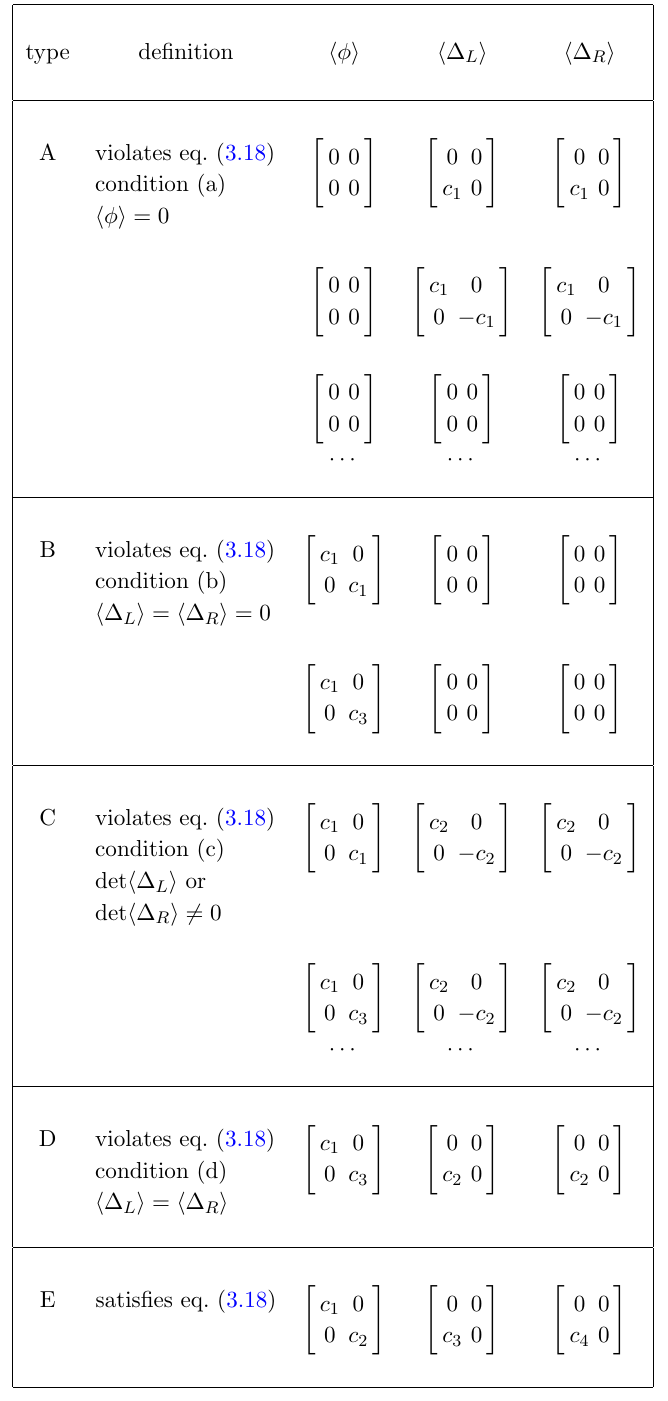
Table 1 . VEV alignments of various types of minima found in the numerical search. Except for type E, each type is de(cid:12)ned by a relation that violates the good vacuum conditions in eq. (3.18). The typical VEV alignments in each type are listed in the 3rd{5th columns, with \ c i " ( i = 1 ; 2 ; 3 ; 4) standing for independent nonzero values. Note that other VEV alignments that can be converted to the ones in this table are not shown (see the main text for more details about this issue), and \ " indicates that the enumeration is not (cid:1) (cid:1) (cid:1)